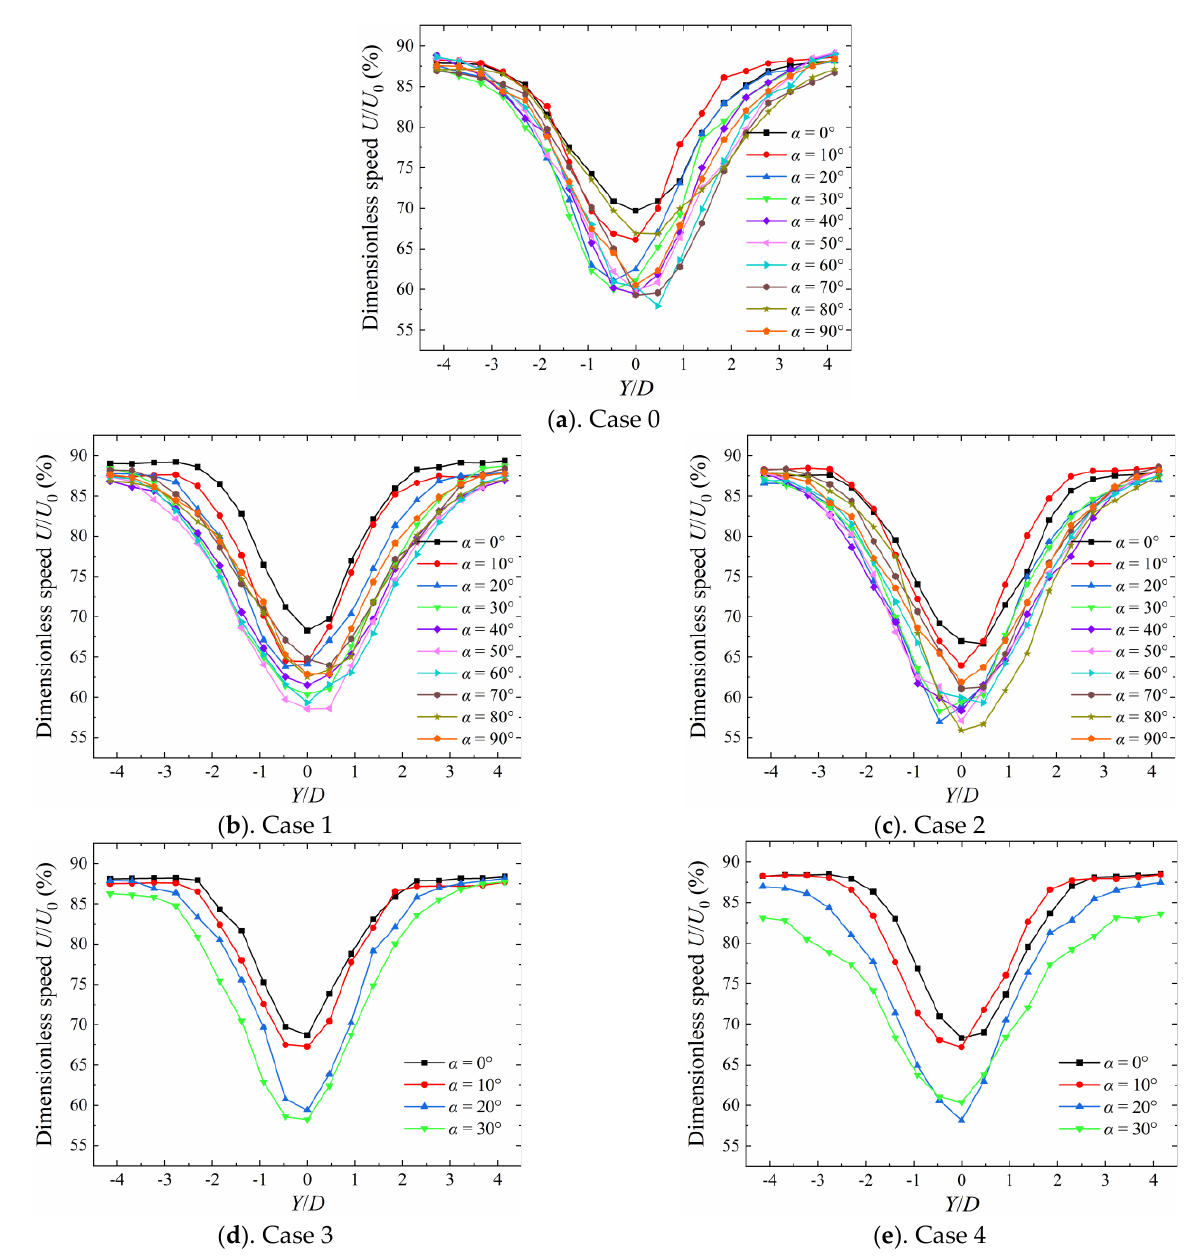
Figure 6. Dimensionless speed distribution at X / B = 8.48.